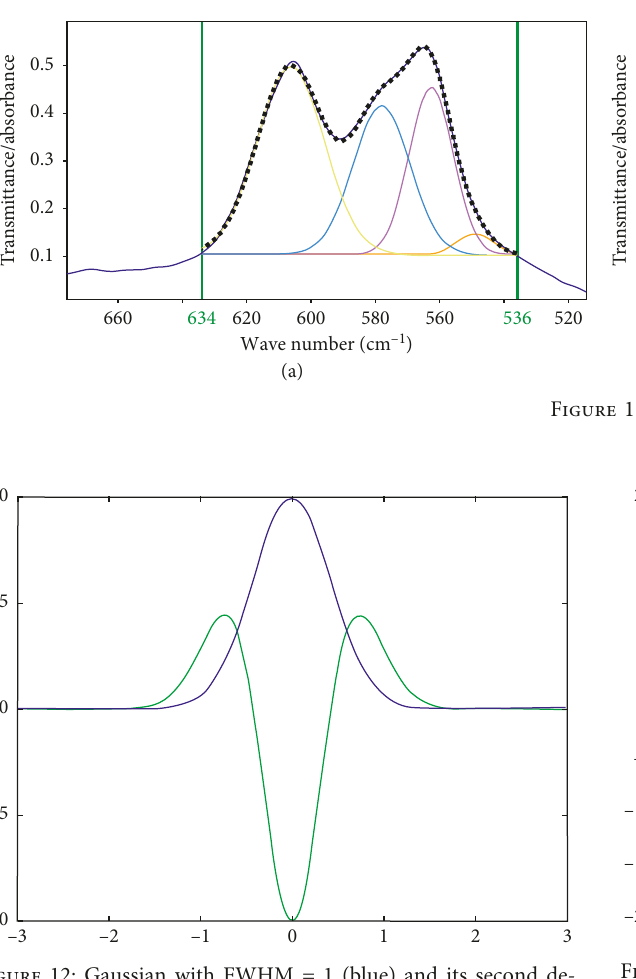
Figure 14. As previously mentioned, the 5 original Gaussian curves (pink) are summed into one spectrum (blue). The second derivative (green) curve shows only 3 minima, which corresponds to the thinner or isolated original peaks. The position of the peak is also slightly shifted. In an ideal analysis, we should get 5 minima corresponding to the 5 original peaks (in abscissa).